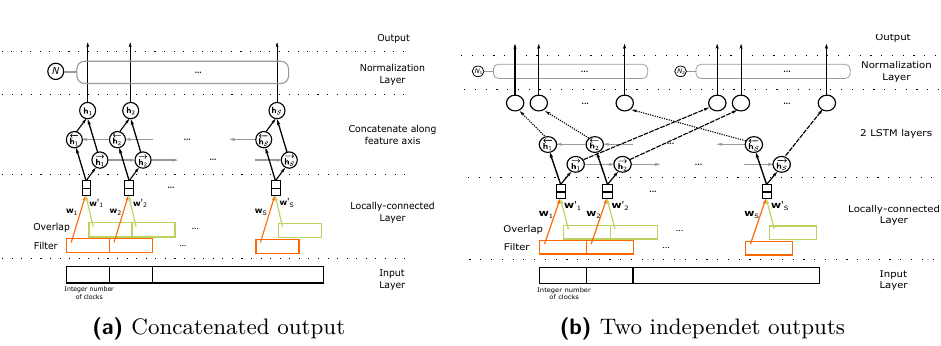
Figure 4: Two encoder instances using different wrapping